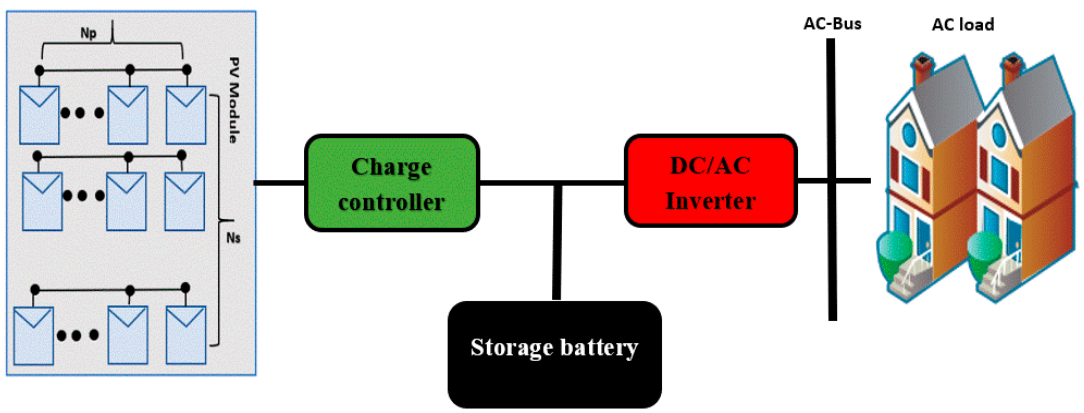
Figure 1. The block diagram of a generalized standalone photovoltaic (SAPV) system.